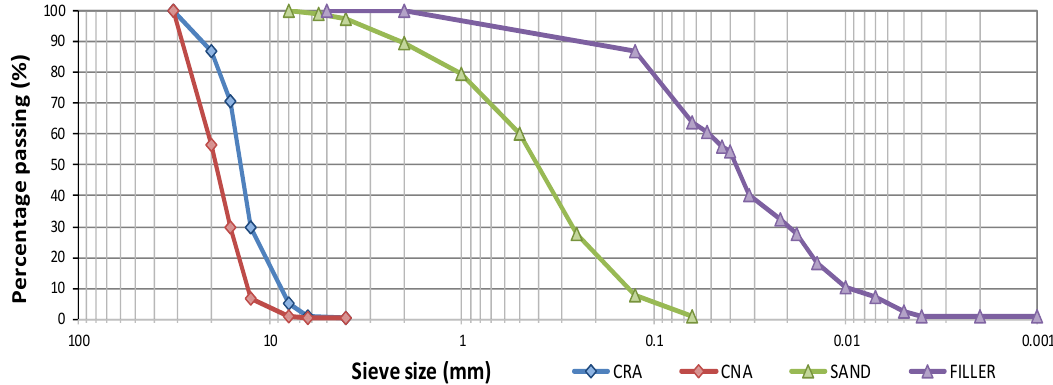
Figure 2. Particle size distribution of natural lime filler, natural sand, coarse natural aggregate (CNA) and coarse recycled aggregate (CRA).